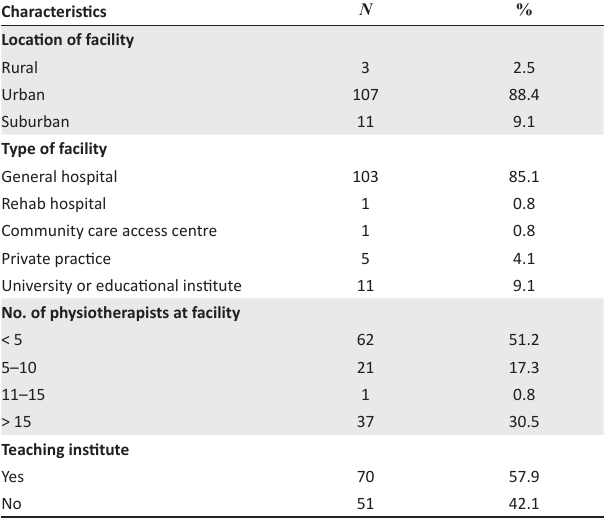
TABLE 2: Characteristics of the practice setting.